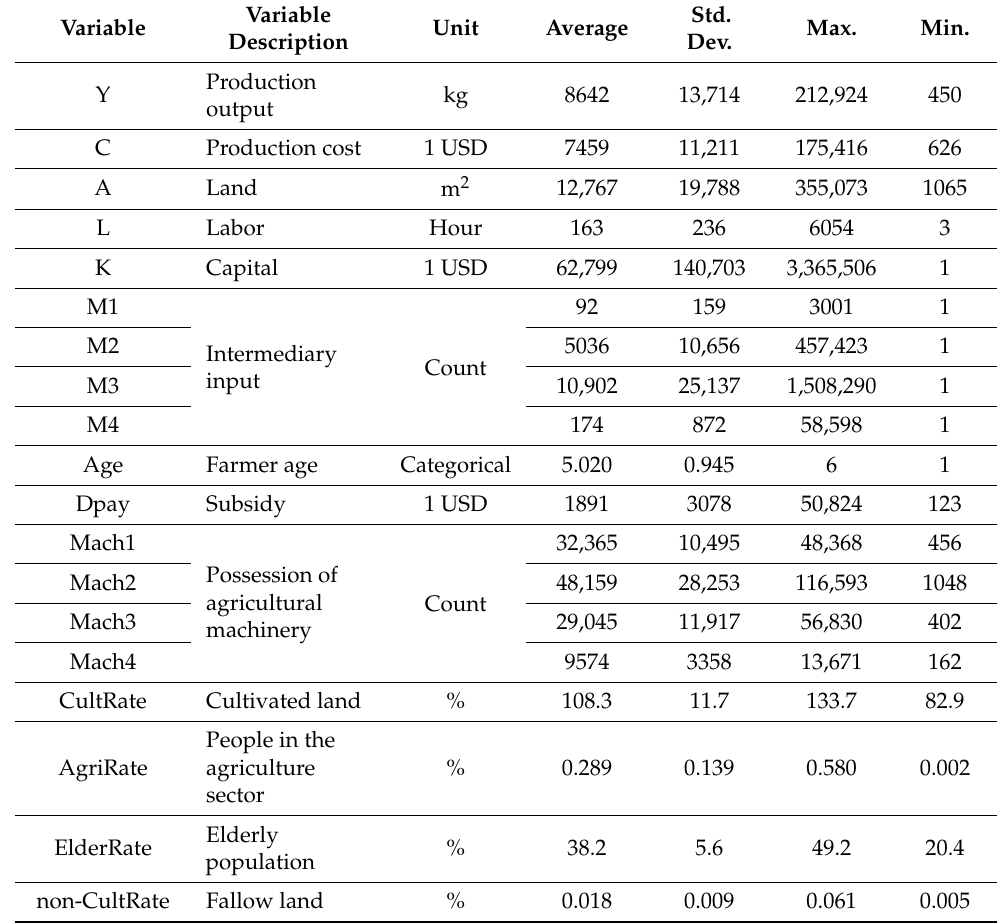
Table 2. Summary statistics of agricultural output and costs estimation variables.